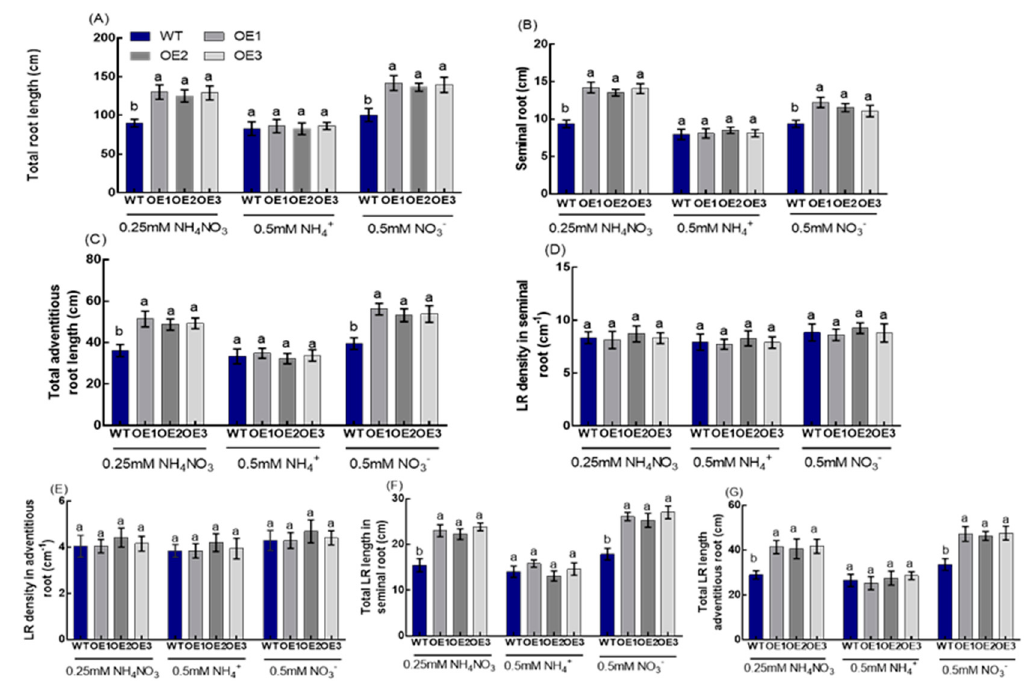
Figure 3. Root morphology of WT and OsNRT2.1 transgenic lines under 0.25-mM NH 4 NO 3 , 0.5-mM NH 4 + , or 0.5-mM NO 3 − conditions. WT and transgenic plants on the 10th day were shown in Figure S2. ( A ) Total root length, ( B ) seminal root length, ( C ) total adventitious root length, ( D ) LR density in seminal roots, ( E ) lateral root (LR) density in adventitious roots, ( F ) total LR length in seminal roots, and ( G ) total LR length in adventitious roots. Total root length is the sum of the seminal root, adventitious roots, and all lateral roots. Error bars: SE ( n = 5). Significant differences between transgenic lines and WT are indicated by different letters ( p < 0.05, one-way ANOVA).